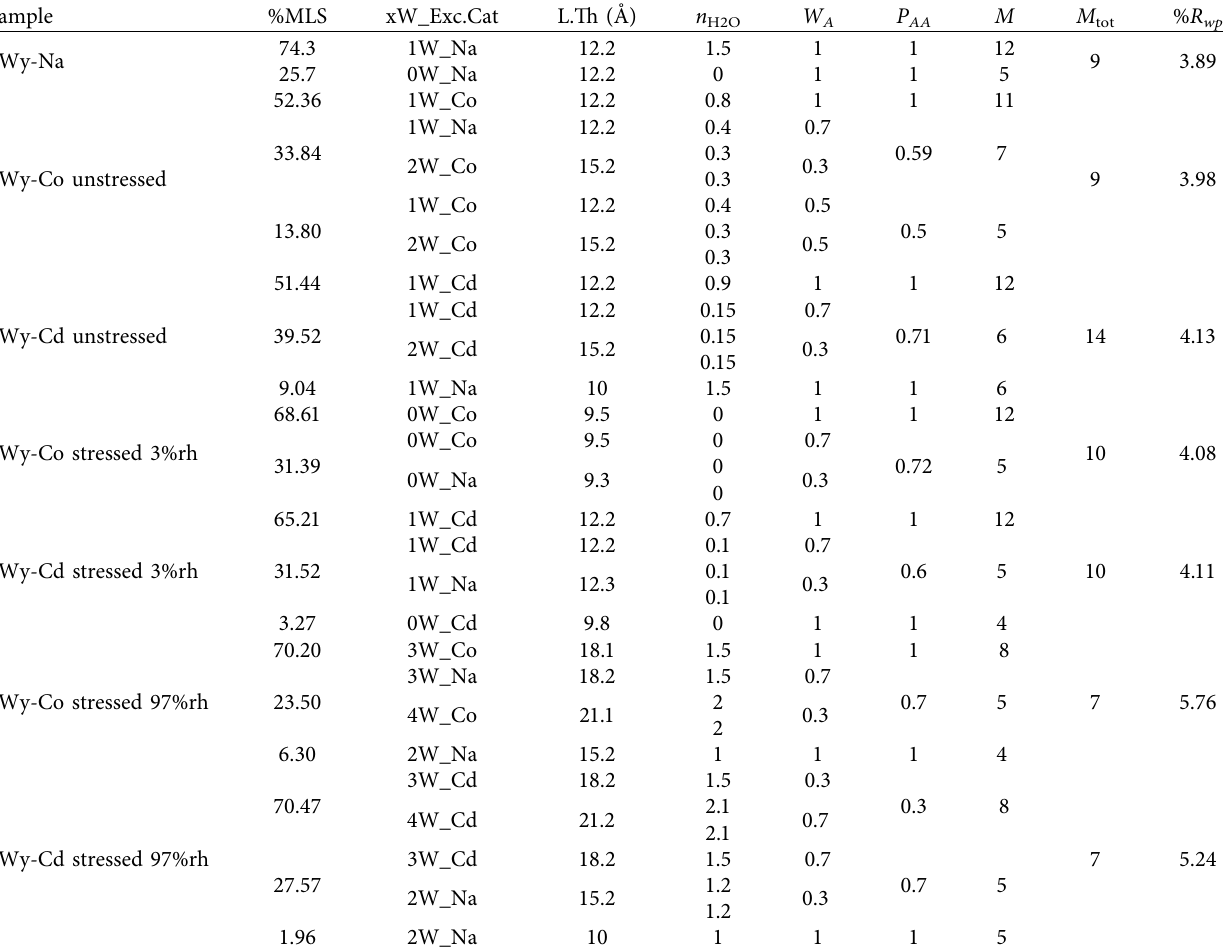
Table 3: Optimal s tructural parameters taken from quantitative XRD analysis for all studied